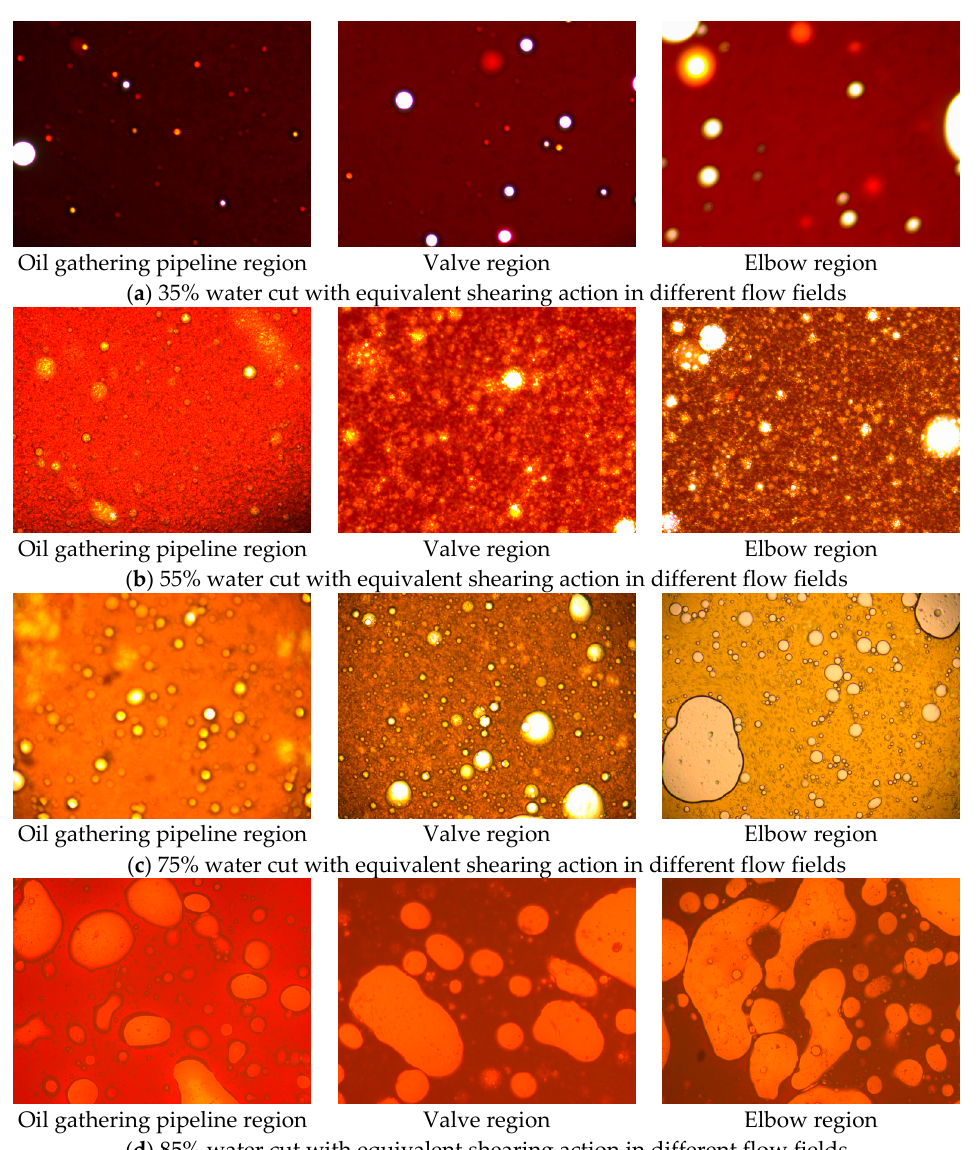
Figure 7. Photomicrographs of the waxy crude oil emulsions.